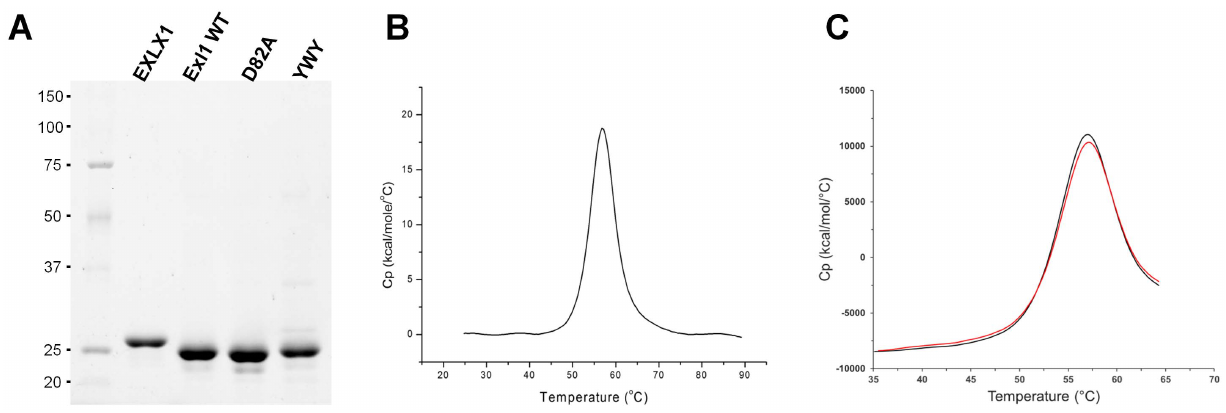
Figure 1. PcExl1 heterologous expression in E.coli produces a structured protein. (a) SDS-PAGE gel of purified P. carotovorum PcExl1 wild- type (WT), and mutants: D82A and Y126A/W127A/158Y (YWY), and comparison to purified B. subtilis BsEXLX1. PcExl1 WT and mutant variants are , 22.9 kDa, whereas BsEXLX1 is , 24.2 kDa. (b) Thermal denaturation of a solution of 0.4 mg/ml PcExl1, carried out at 90 K/h, showed a two-state process that occurs at 56.8 u C. (c). PcExl1 denaturation is reversible after heating at 65 u C (red line), under the same heating conditions as in (b).